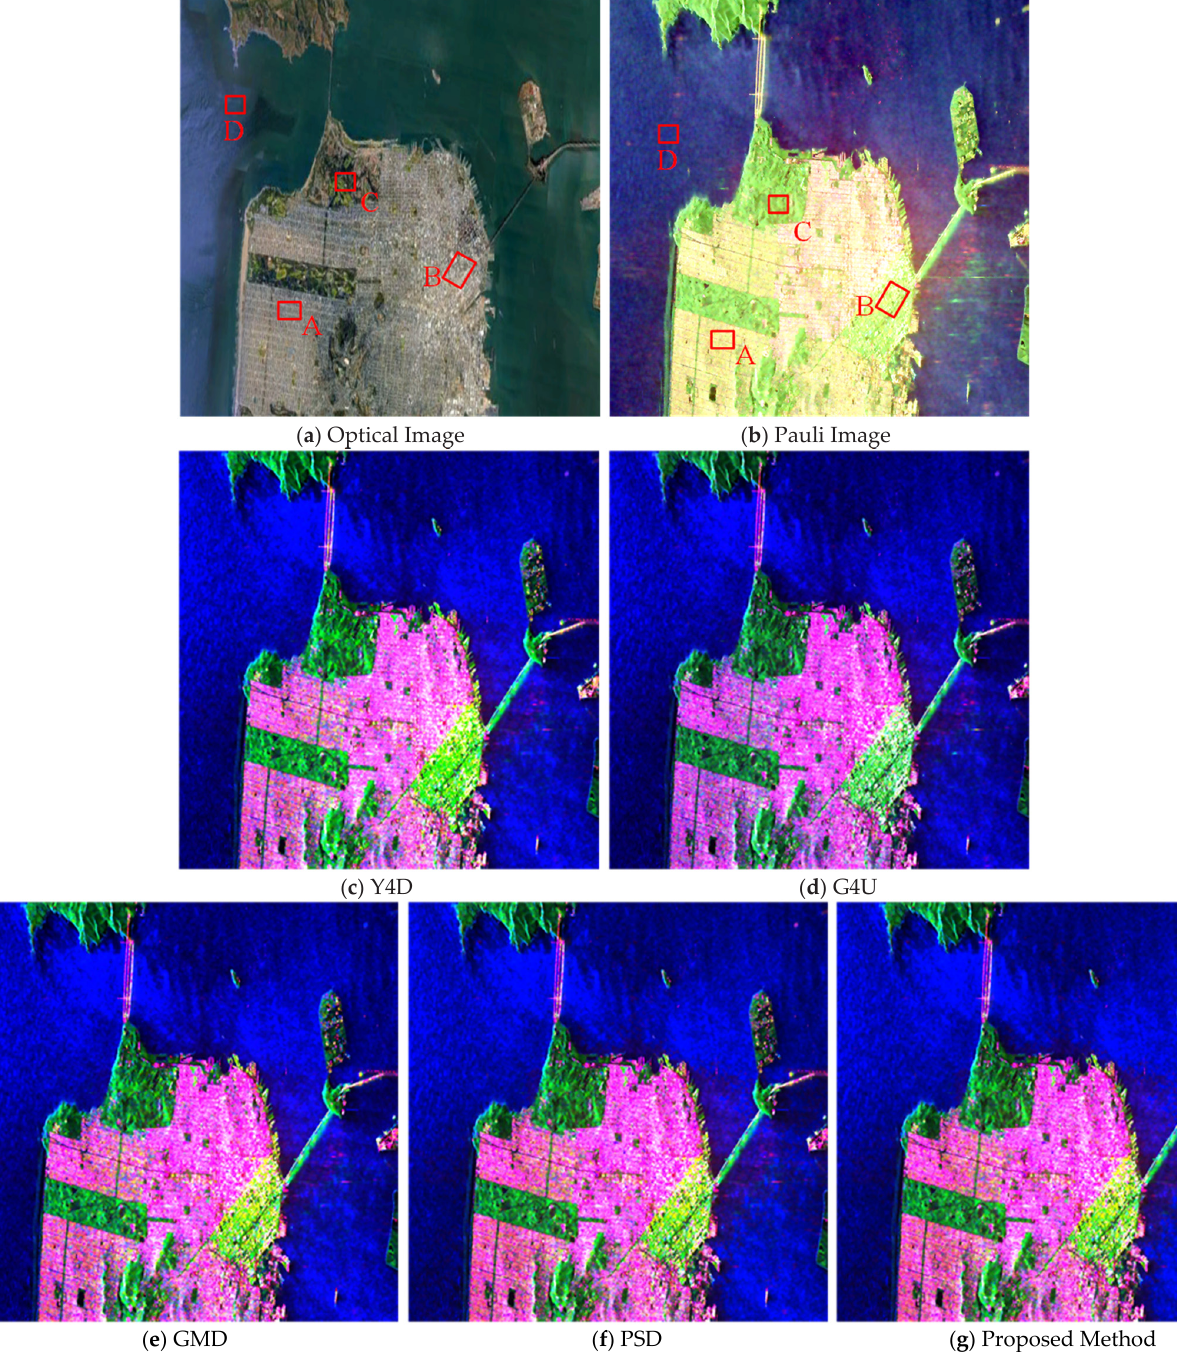
Figure 6. Decomposition results of Radarsat-2 data. ( a , b ) are the optical image and Pauli image. ( c – g ) are the decomposition result of different decomposition methods. The images are colored by Pd (red), Pv (green), and Ps (blue).